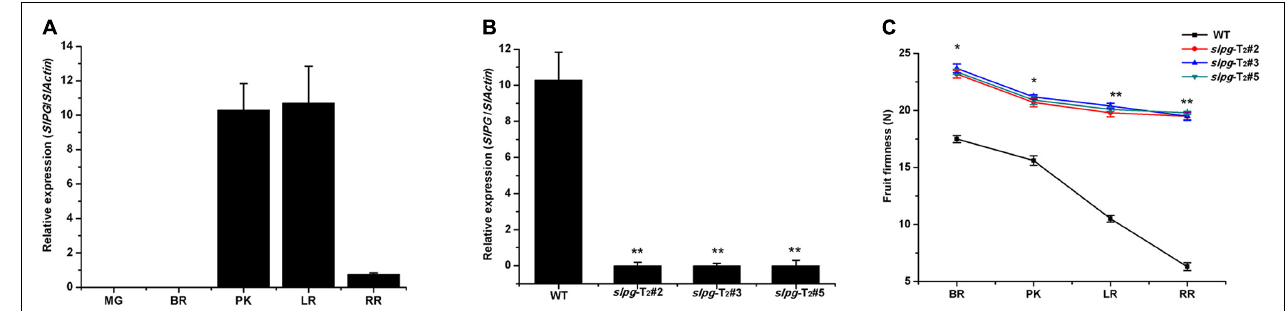
FIGURE 2 | Expression patterns of SlPG and phenotype identification of tomato slpg mutant. (A) Expression of SlPG in fruit at different developmental stages: MG, BR, PK, LR, and RR; (B) Expression of SlPG in WT plants and T 2 homozygous slpg mutants ( slpg -T 2 #2, slpg -T 2 #3, and slpg -T 2 #5). Relative transcript levels of SlPG were analyzed by qRT-PCR and normalized to SlActin . Quantitative PCR data represent means values for three independent biological replicates ( n = 3); (C) Phenotype of enhanced fruit firmness at different fruit development stages in slpg mutants. The fruit firmness values represent the means ± standard error (SE) of 20 individual fruit per line at each stage. * and ** indicate significant differences between WT plants and T 2 homozygous slpg mutants ( slpg -T 2 #2, slpg -T 2 #3, and slpg -T 2 #5) with p < 0.05 and p < 0.01, respectively, as determined by t